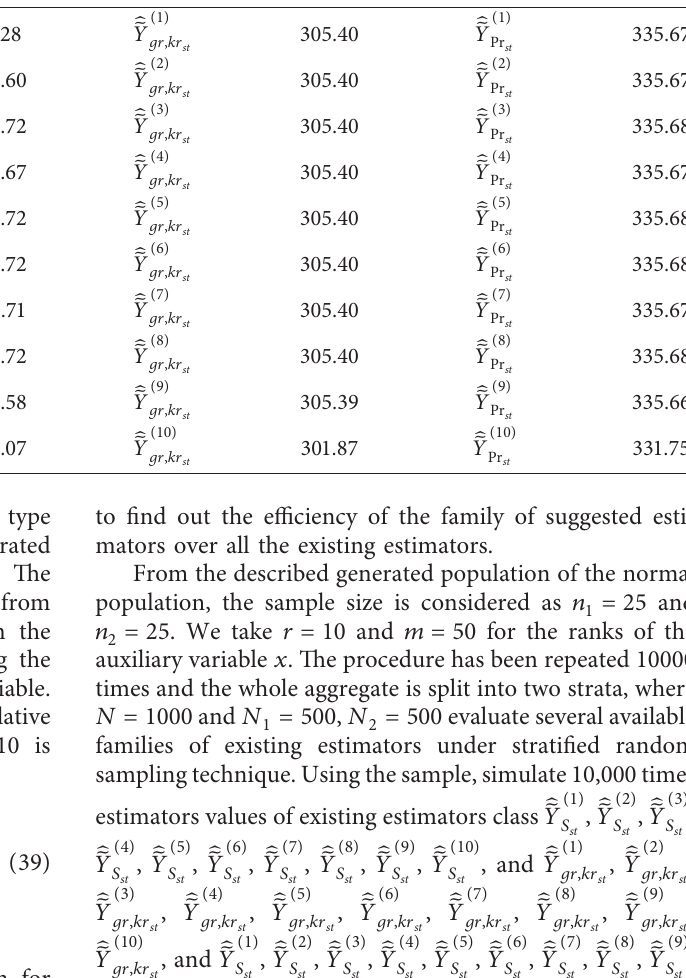
Table 14: PREs of finite population mean estimators using population 2 (scenario II). Estimator